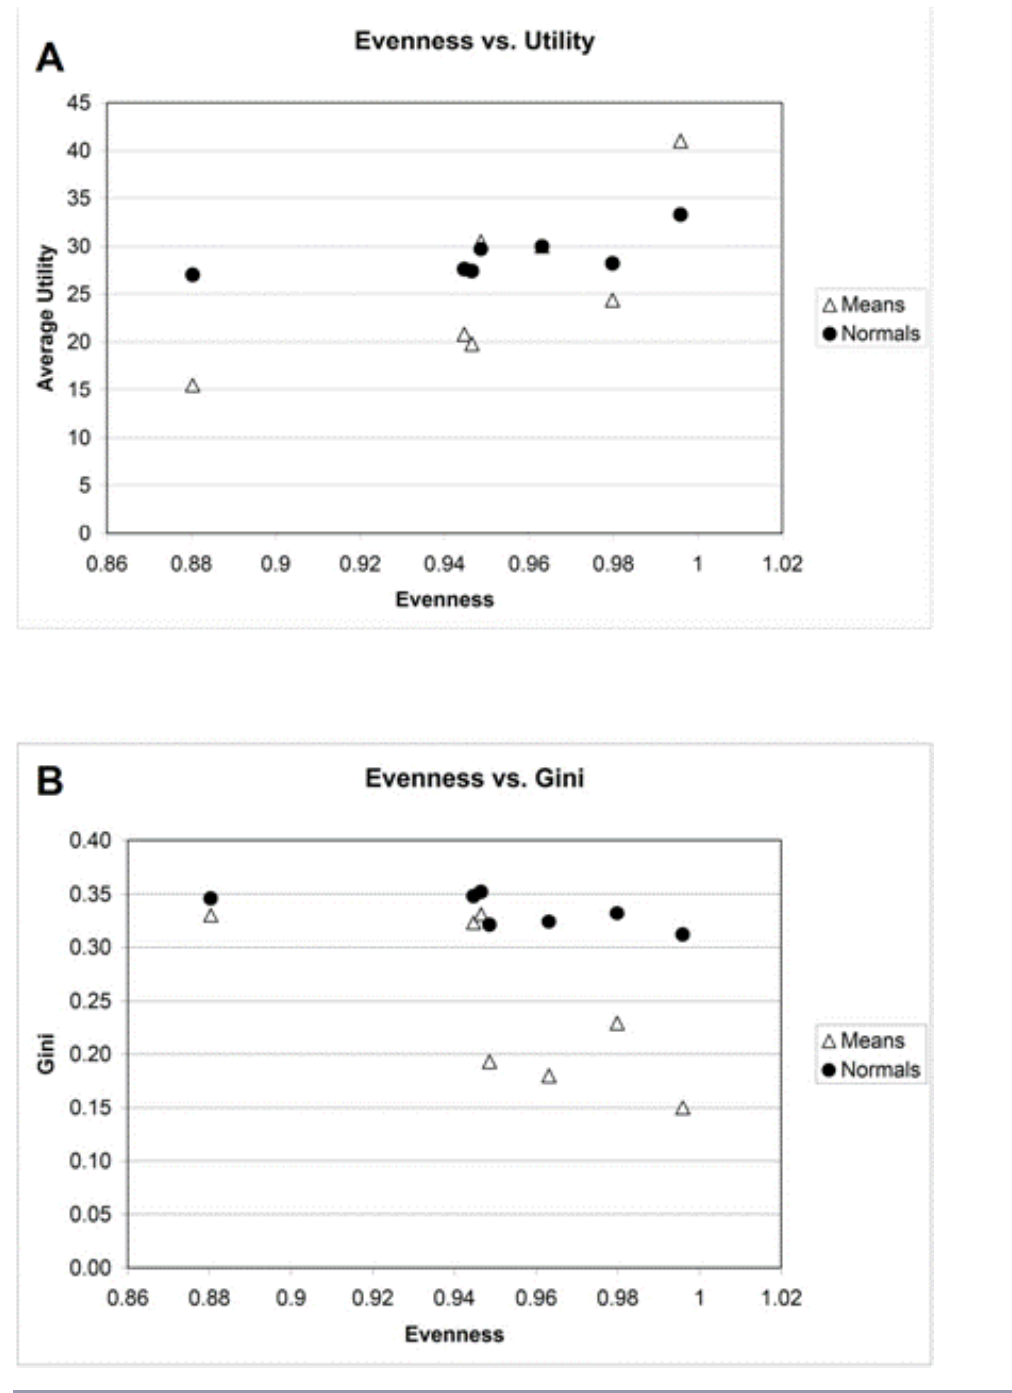
Fig. 5. Relationships of evenness of agent preferences by group with A) average utility and B) Gini coefficient of disparity in